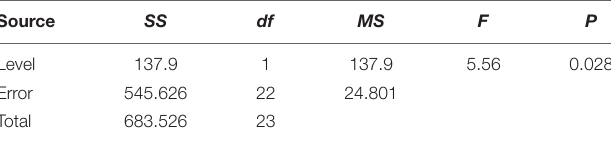
TABLE 6 | Non-parametric ANCOVA (Quade